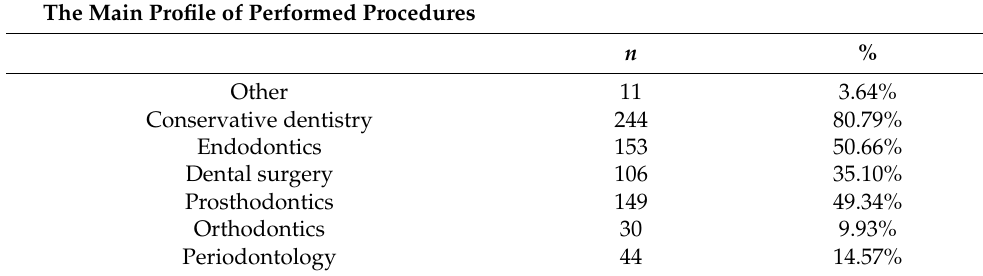
Table 1. The profile of performed procedures. The Main Profile of Performed Procedures